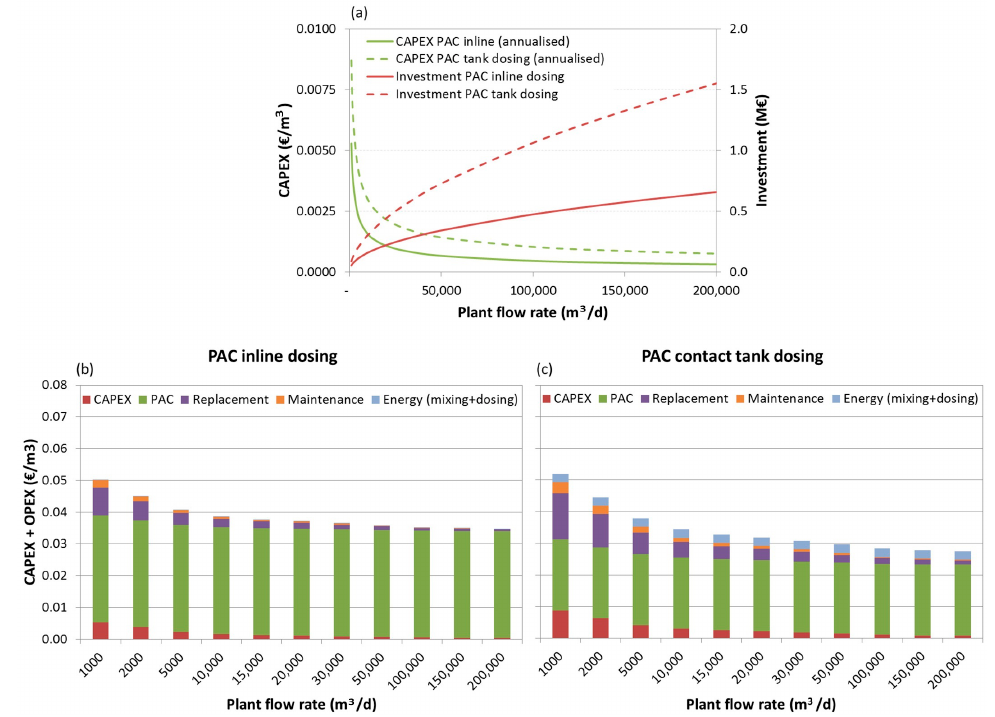
Figure 7. Investment costs and annualised CAPEX ( a ) and total (CAPEX+OPEX) production costs breakdown for scenario 2, dosing 12 mg/L PAC inline ( b ) and 8 mg/L PAC to tank ( c ).